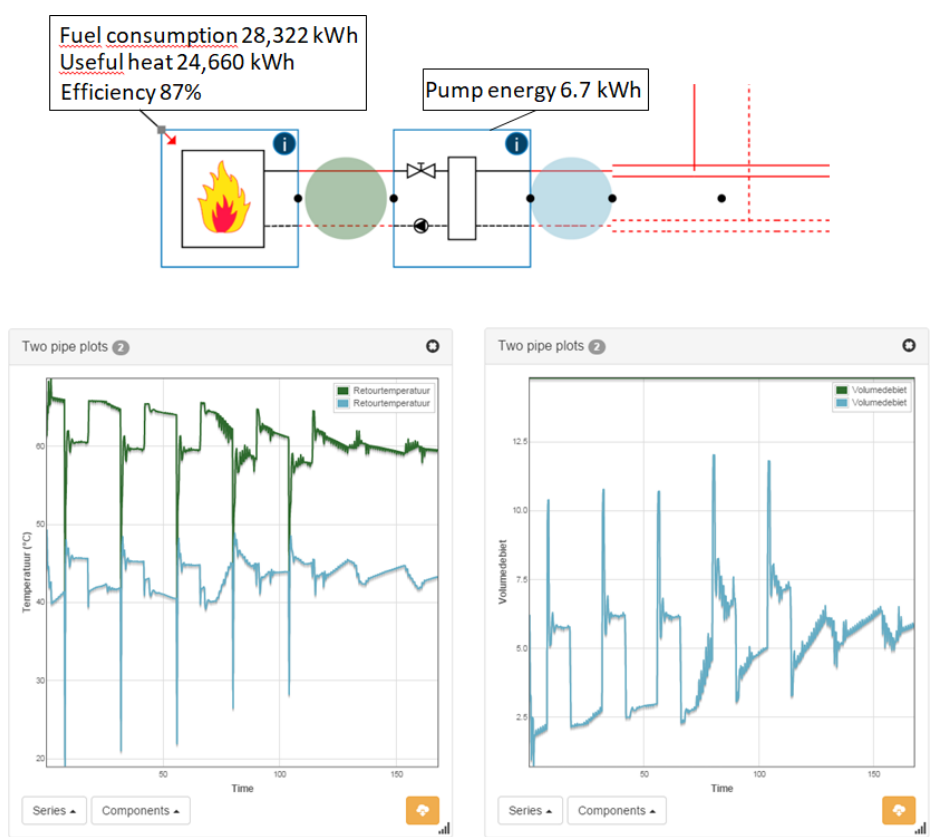
Fig. 23. – Simulation of the return temperature (left) and the flow rate (right) before and after the low loss